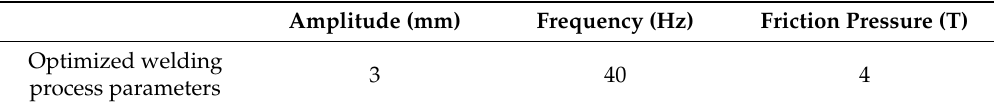
Table 2. Welding process parameters.